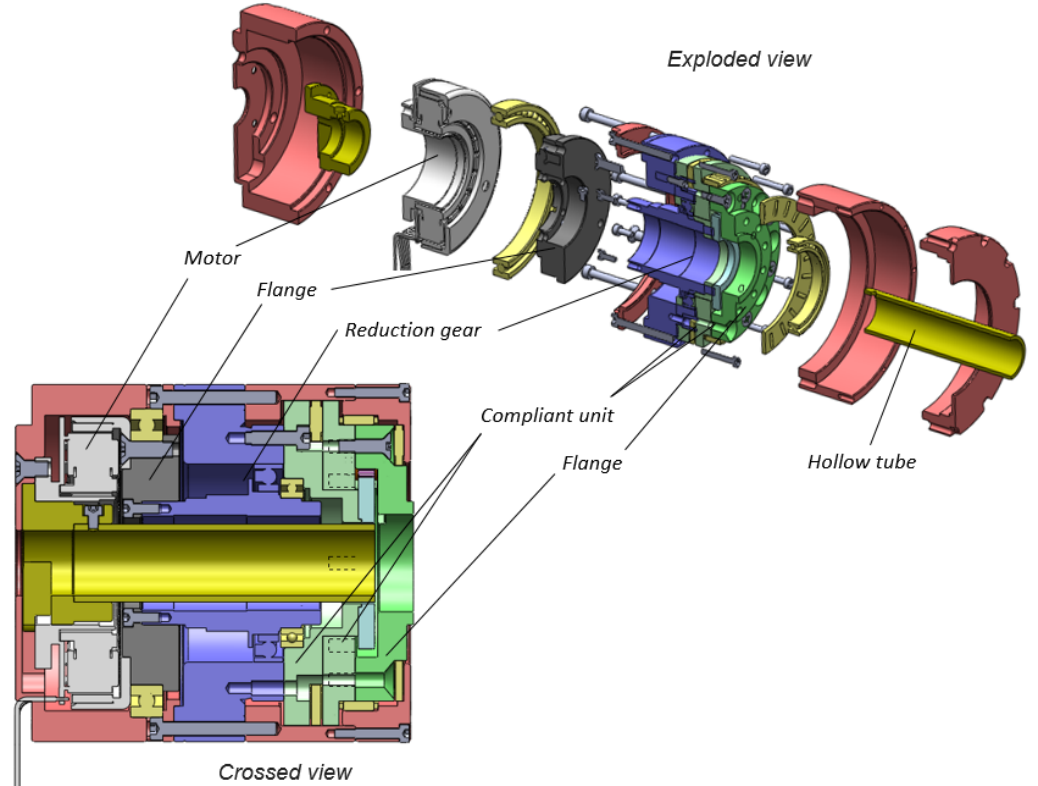
Figure 4. Mechanical design of hollow modular compliant